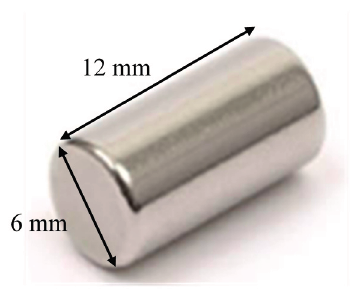
Figure 6. A 12 × 6 mm neodymium